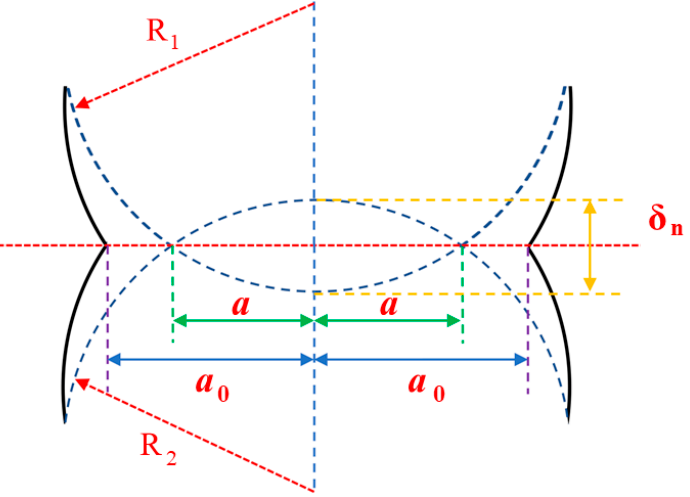
Figure 1. Deformation surface (rough line) considering cohesive force.